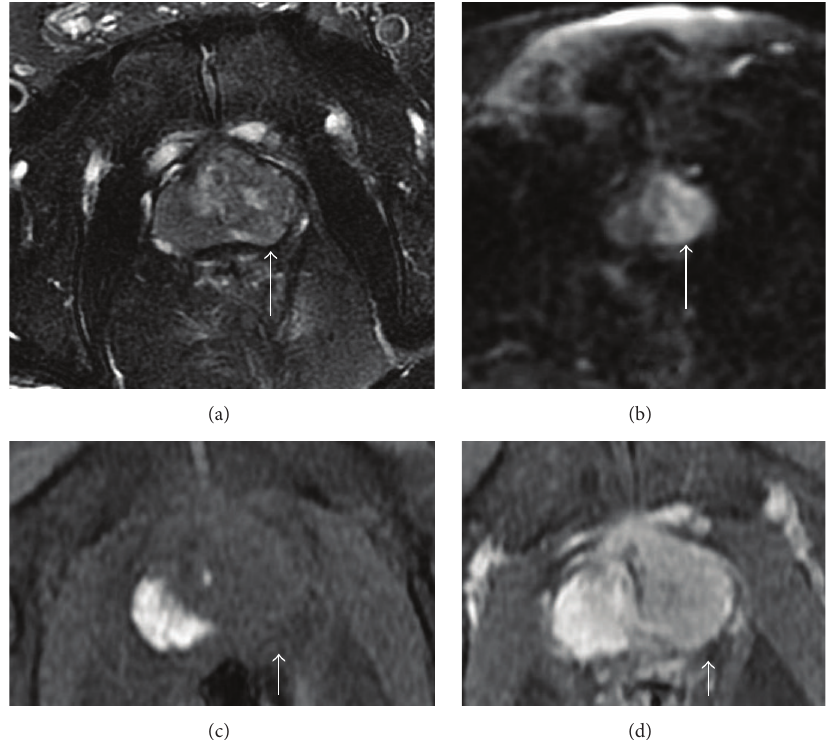
Figure 1: On MRI, T1 weighted image showed diffusely spread tumor in the left side of the prostate (white arrow). This lesion was heterogeneous on T2 weighted images (a), high intensity on diffusion weighted images (b), and well enhanced by contrast agent ((c) T1 weighted image, (d) contrast-enhanced T1 weighted image).